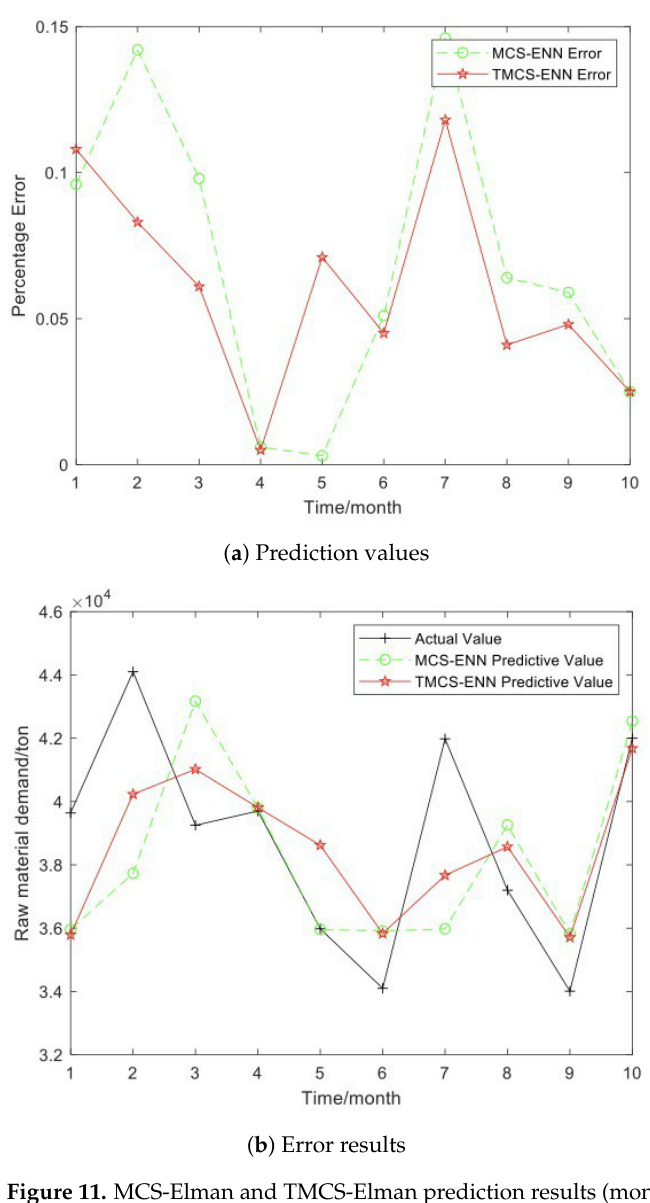
Figure 11. MCS-Elman and TMCS-Elman prediction results (month).